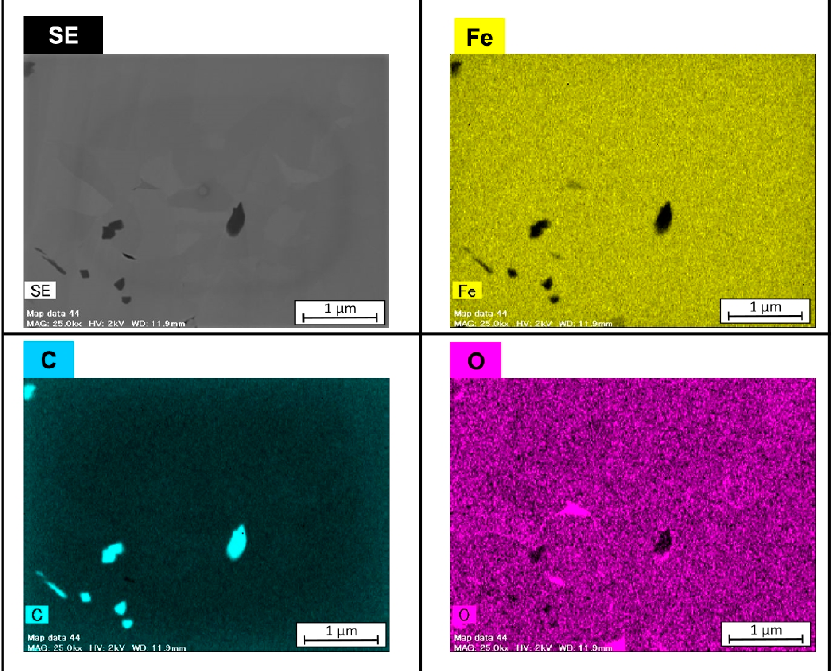
Figure 7. SEM image of Fe–MWCNT composite plating layer and its EDS mapping analysis results.